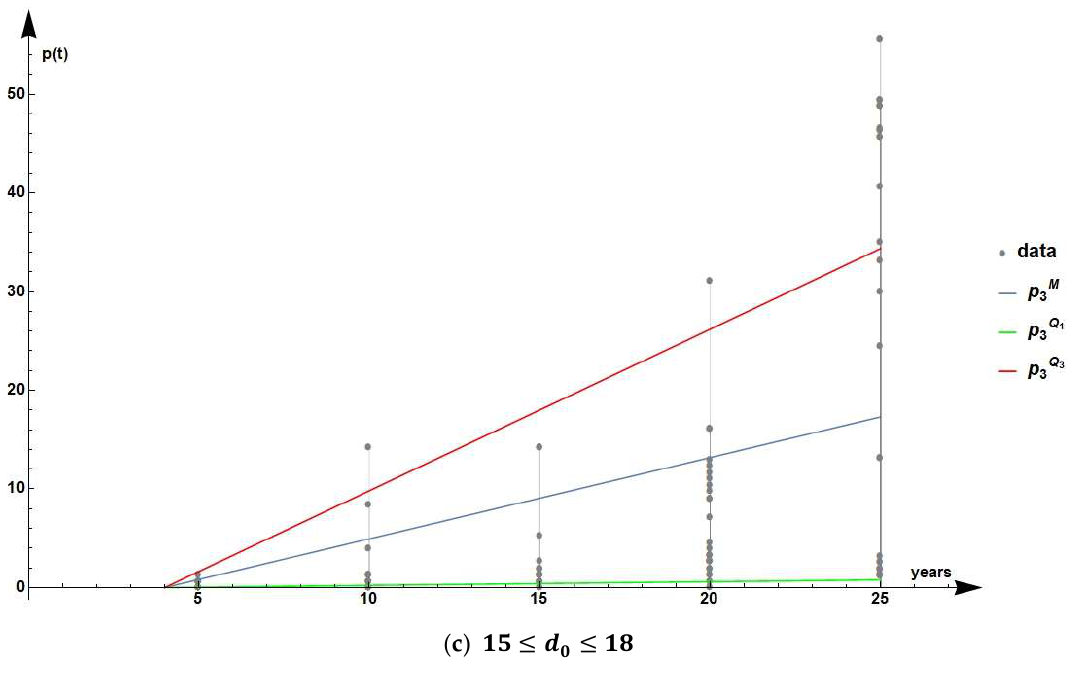
Figure 3. Linear models for the minimum ( a ), mean ( b ), and maximum ( c ) corrosion wear percentage of the LG ship structures.